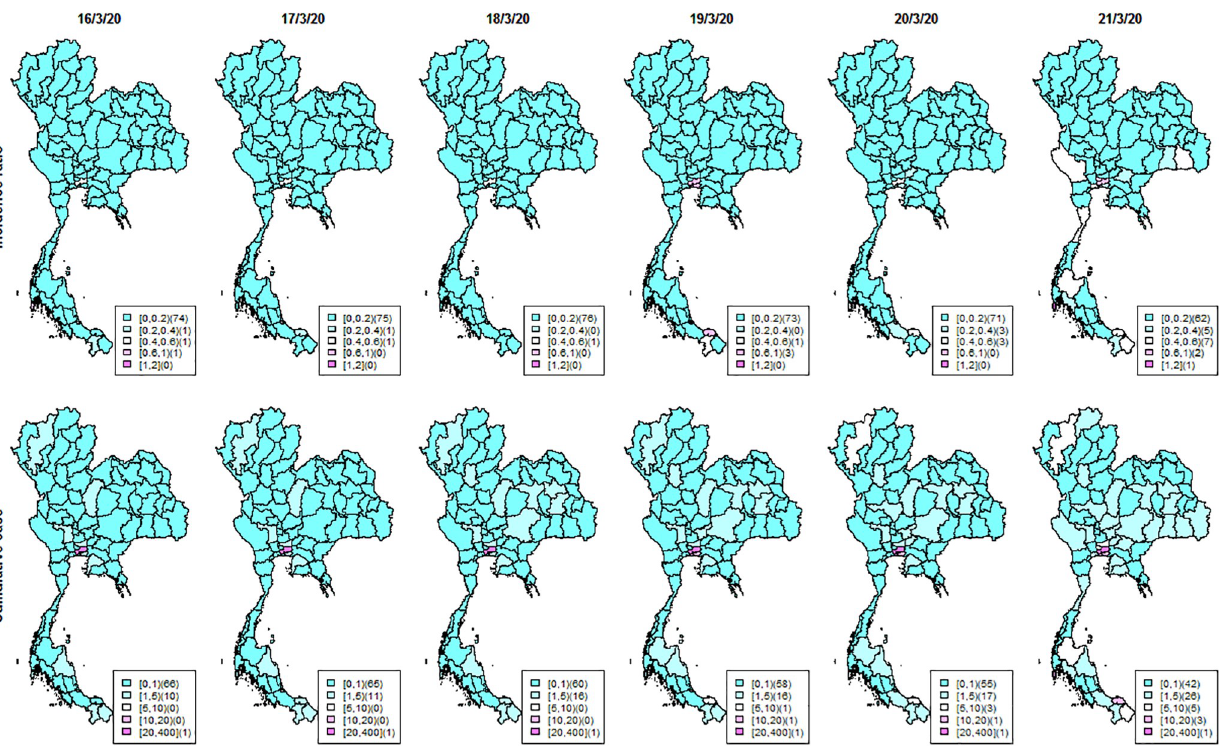
Fig 2. Maps of Thai COVID-19 standardized incidence ratio per 100,000 population and cumulative cases during March 16 th –March 21 st 2020 at provincial level.